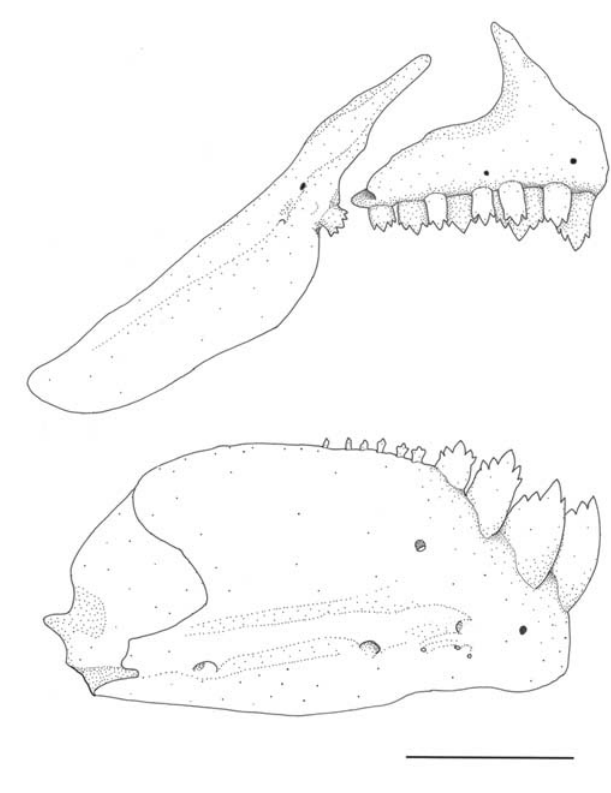
Fig. 2. Moenkhausia forestii , new species, paratype, MZUSP 90270, 33.1 mm SL, premaxillary, maxillary and dentary; right side, lateral view (maxillary and dentary) or frontal view (premaxillary). Scale bar = 1